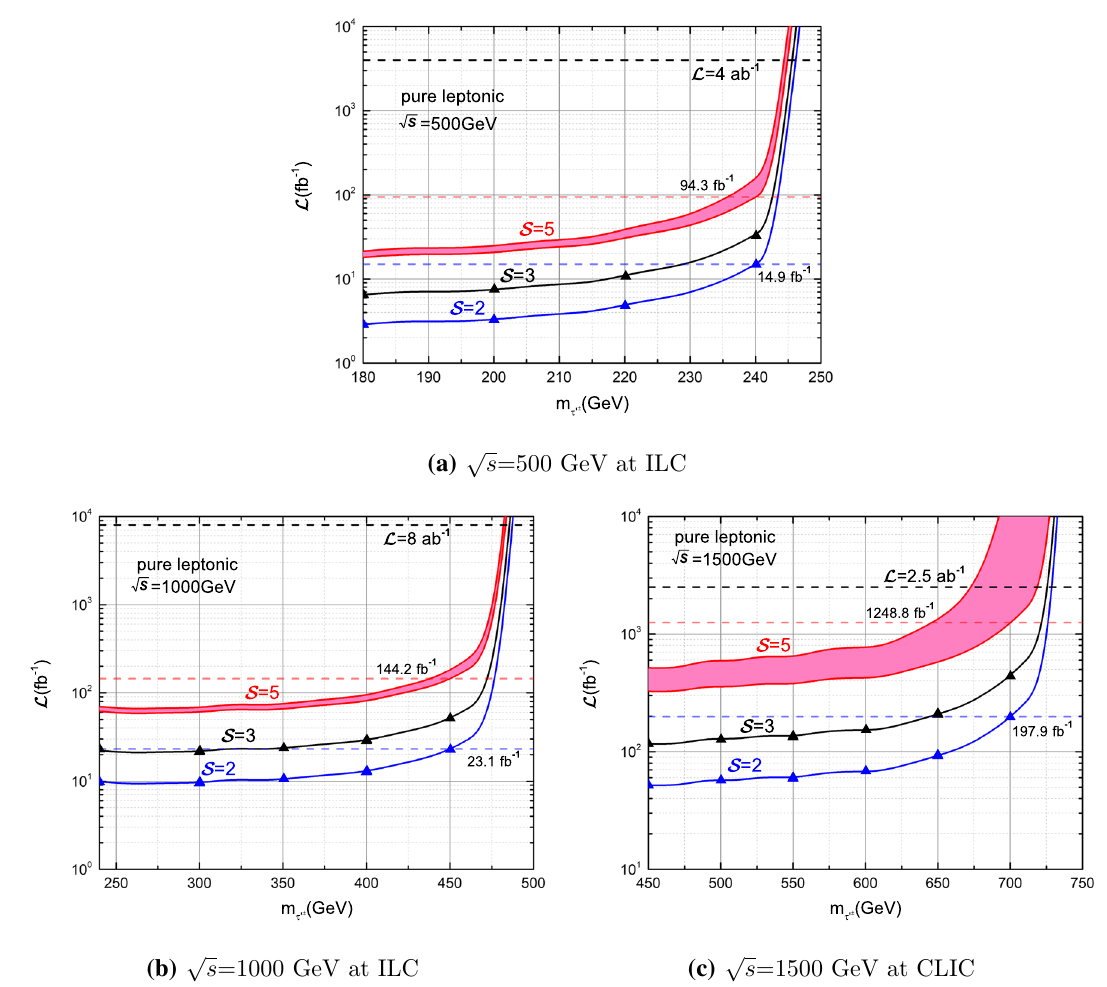
√ √ s =1000 GeV at ILC (c) s =1500 GeV at CLIC (b) Fig. 8 The contour plots of S = 2 (blue solid line), S = 3 (black the integrated luminosity for excluding (discovering) the mass region m τ (cid:2)± ∈ [ 180 , 240 ] GeV in a , [240,450] GeV in b and [450,700] GeV solid line) and S = 5 (red solid line) in the L ∼ m τ (cid:2)± plane for pure leptonic channel. The horizontal dashed black line is the highest inte- in c . For discovery S = 5, the surrounding red band corresponds to the grated luminosity, and the horizontal dashed blue (red) line stands for significance considering the systematic uncertainties σ B = 0 . 3 ∗ B